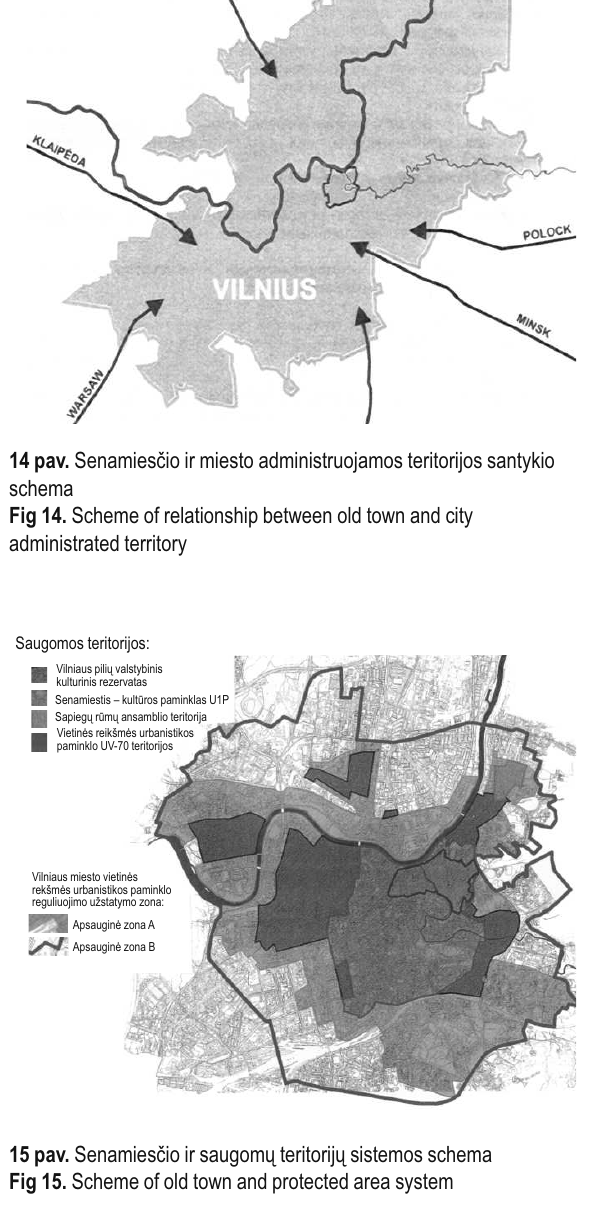
Fig 15. Scheme of old town and protected area system neišvengiamos miesto plėtros išraiška. Kita vertus, reikia įvertinti tą faktą, kad šis autorinis projektas realizuoja- mas Vilniaus Senamiesčio vizualinės apsaugos